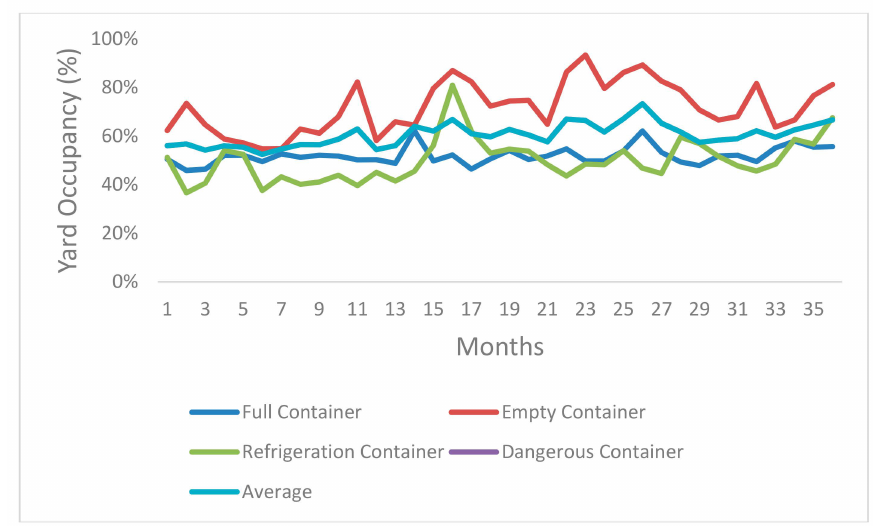
Figure 6. Monthly Yard Occupancy Rate (%) over 3 years (2014–2016).